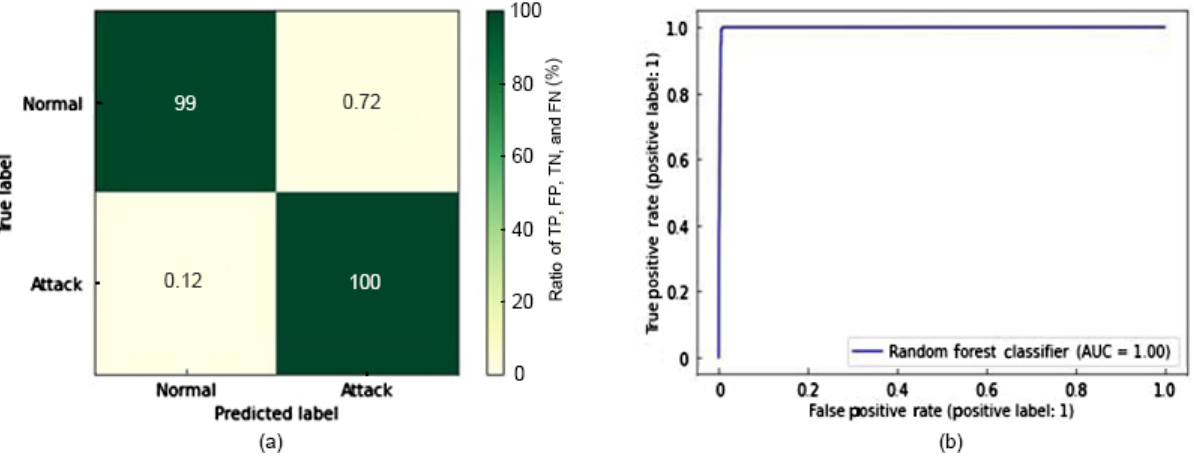
Fig. 16 Confusion matrix and ROC curve of RF-IFPCC on the NF-UNSW-NB15-v2 dataset.